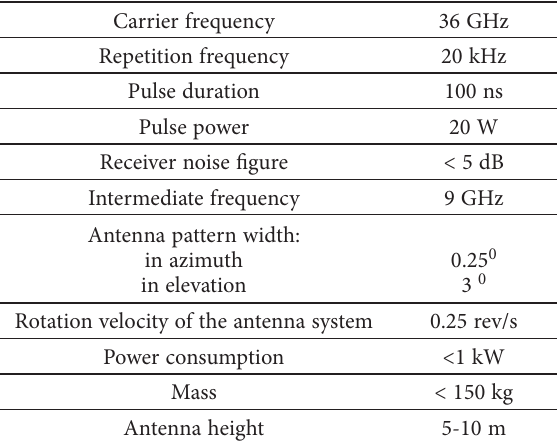
Table 1. Major characteristics of the radar sensor Carrier